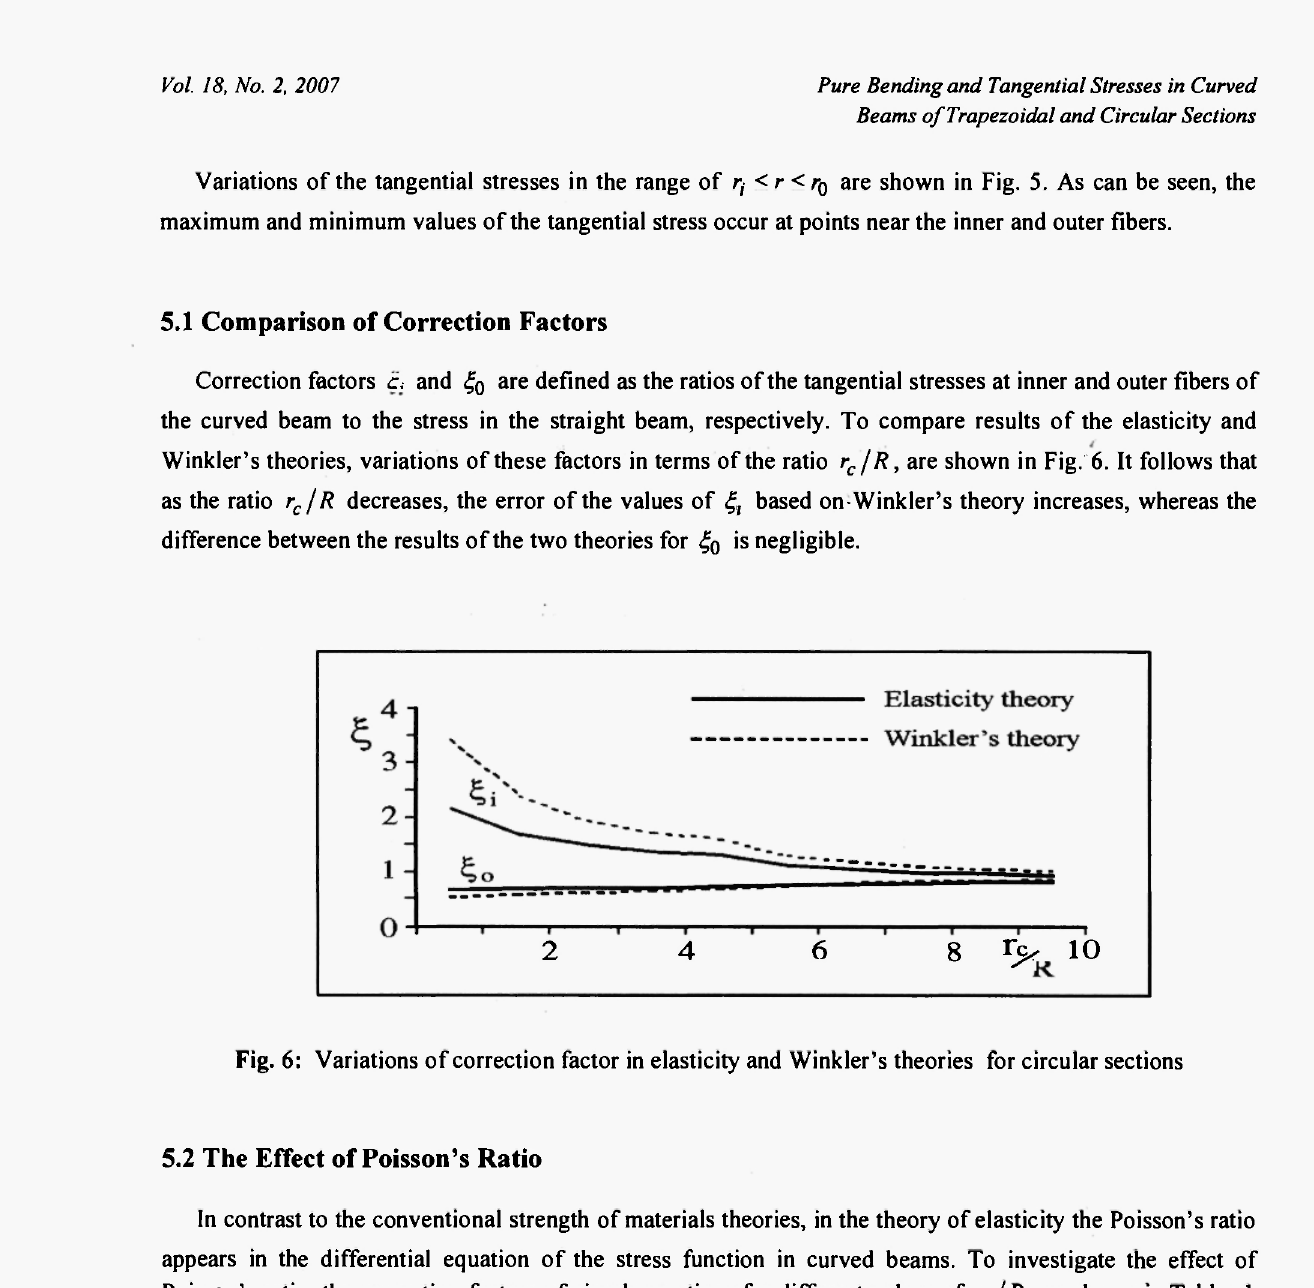
Fig. 6: Variations of correction factor in elasticity and Winkler's theories for circular